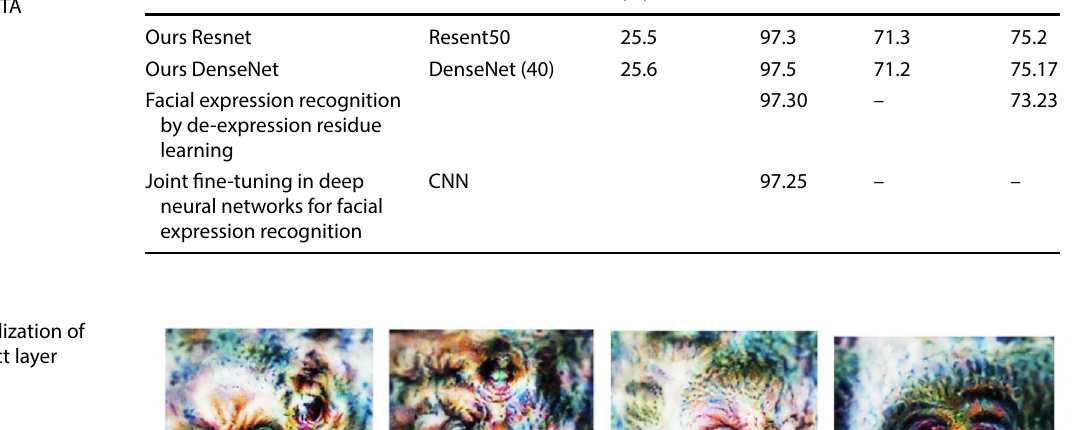
Table 7 Comparison of recognition accuracy between our method and SOTA